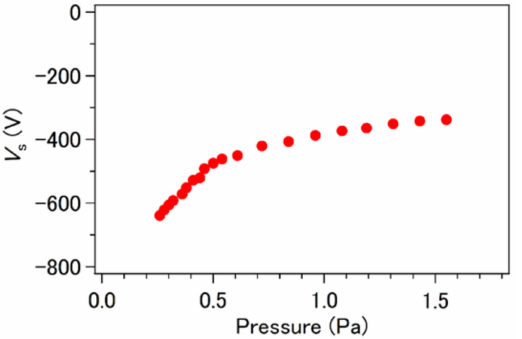
Figure 6. Breakdown voltage V s as a function of the working pressure in MPPMS for working pressure in the range of 0.32 to 1.55